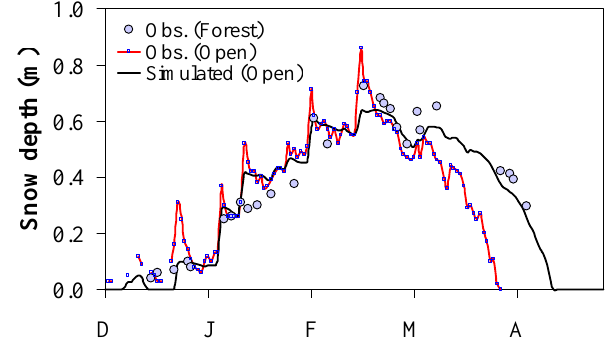
Fig. 11. Comparison of WEB-DHM-S simulated snow depth at HSG open site with observed snow depth at HSG open and forest